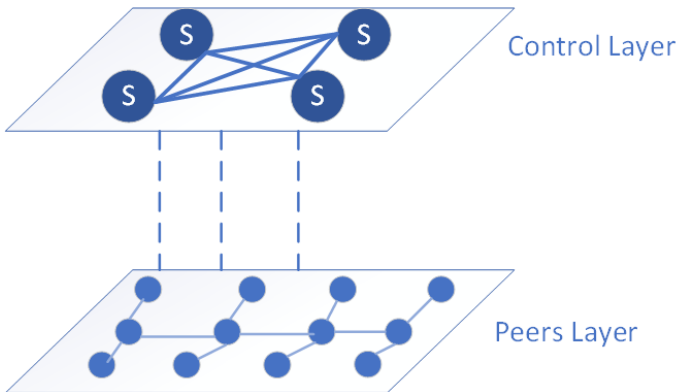
Figure 7. SDN-Inspired Topology Management by Deshpande et al.